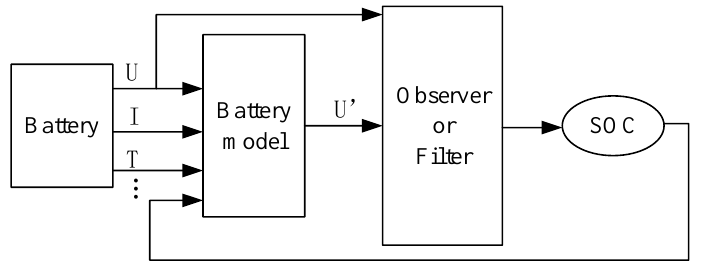
Figure 6. Structure diagram of SOC estimation method based on state space battery model.